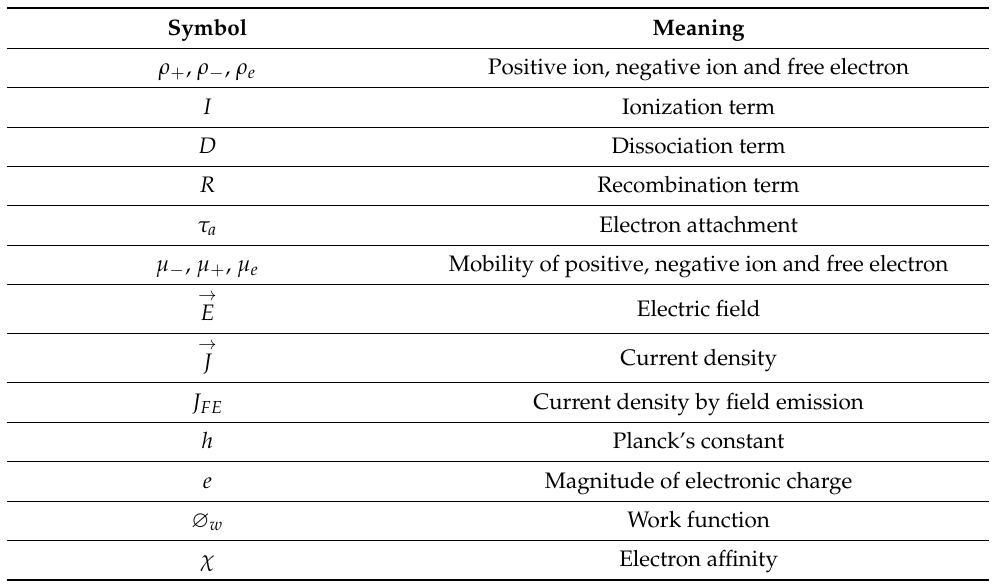
Table 1. Abbreviations and acronyms used in this